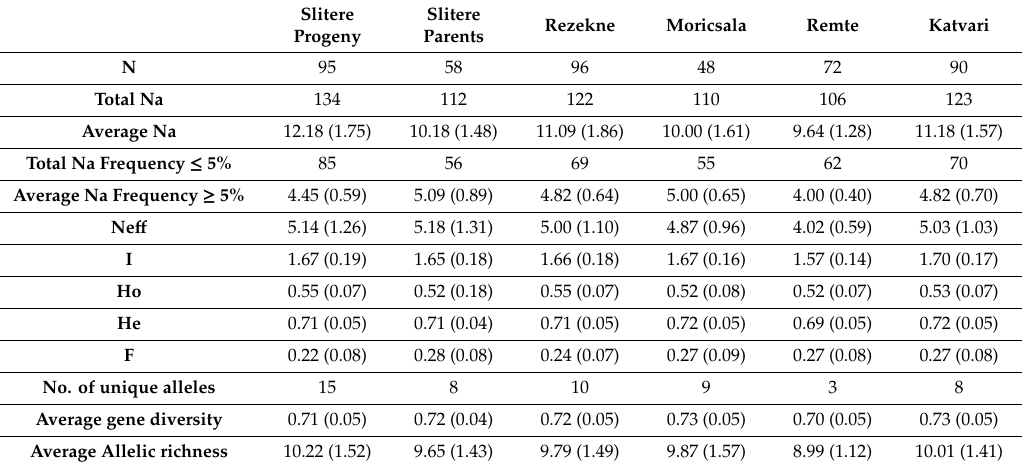
Table 3. Genetic diversity indicators in the analyzed Norway spruce